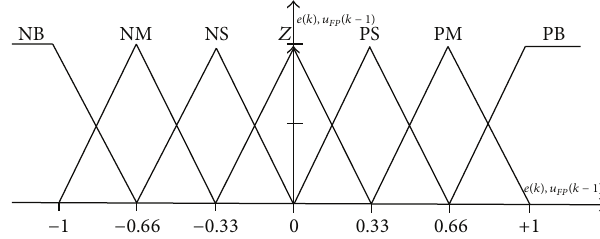
Figure 5: Membership functions for input and output variables.